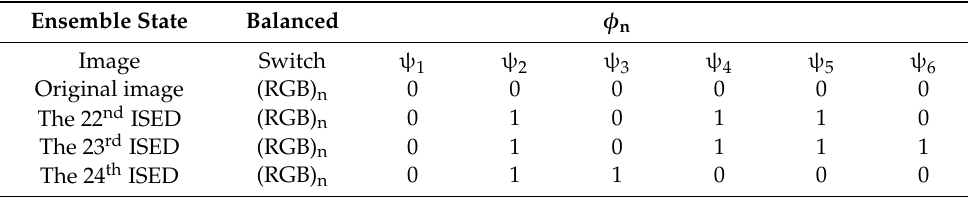
Table 2. Balanced state ensembles of ISED generated images in Figure 5a–c.